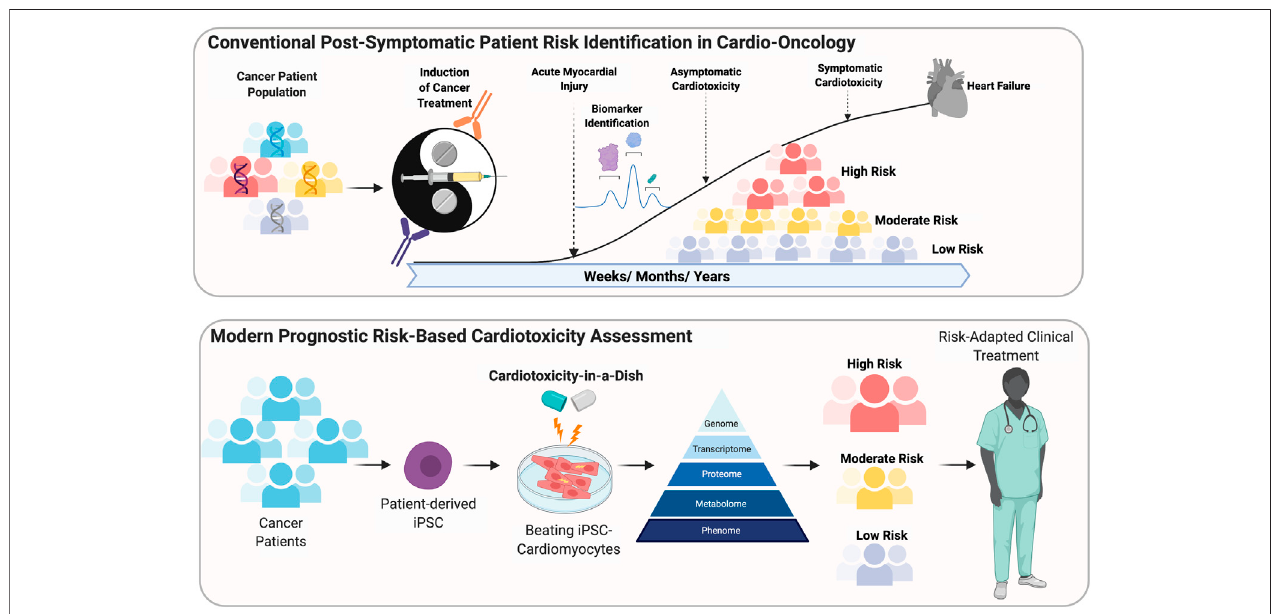
FIGURE 1 | Conventional post-Symptomatic patient risk indenti fi cation in Cardio-Oncology. Modern prognostic risk-based cardiotoxicity assessment.